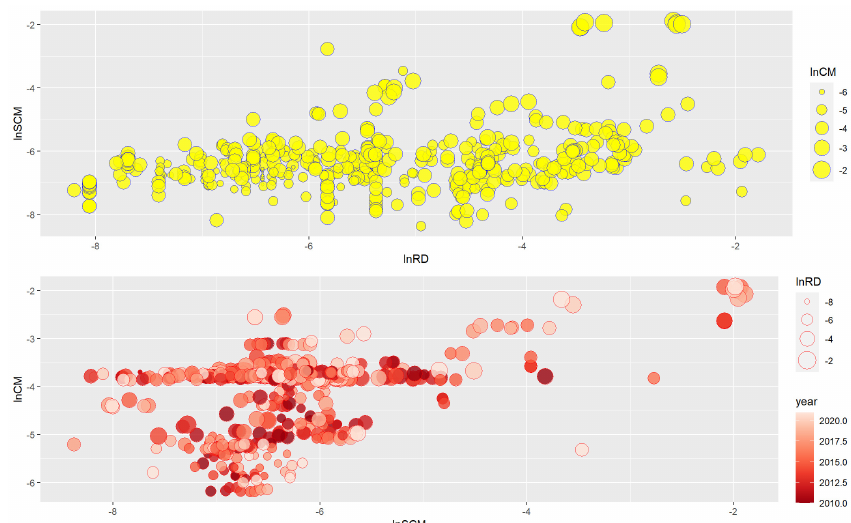
Figure 2. The scatter plot above (in yellow) represents: the relationship between R&D innovation (lnR&D) and supply chain management (lnSCM); the scatter plot below (in red) represents: the relationship between corporate management (lnCM) and supply chain management (lnSCM).